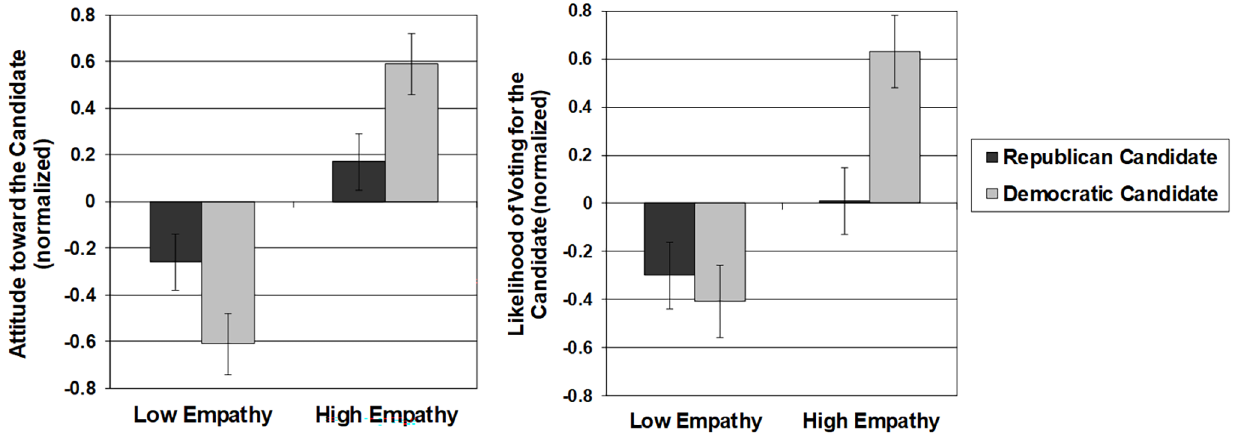
Figure 2. Two-way interactions between candidate party affiliation and displays of empathy by the candidate on attitudes toward the candidate and likelihood of voting for the candidate (Study